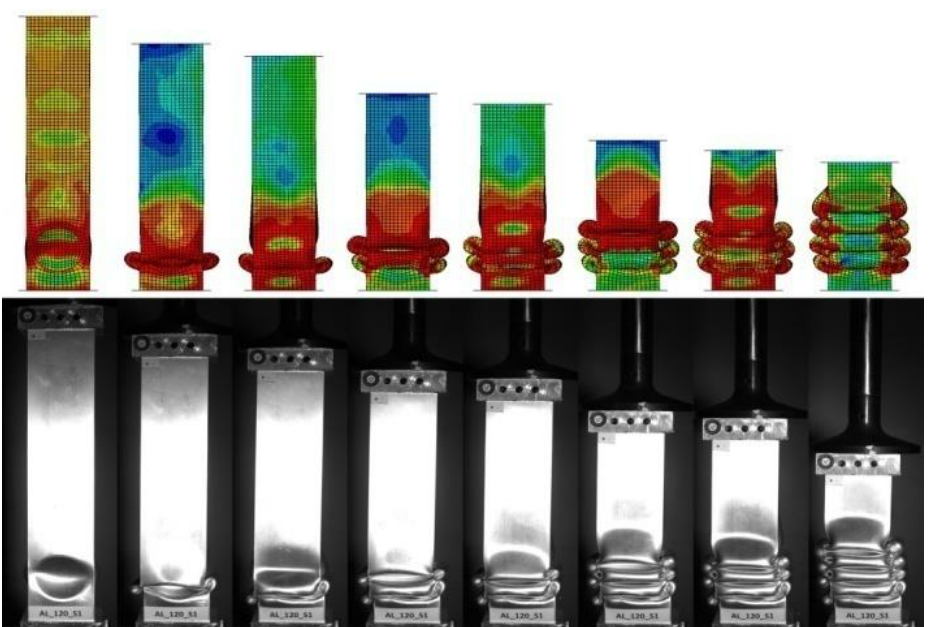
Figure 13. Comparison form of the crushed absorber in different stages of dynamic analysis for 120 mm length foam.